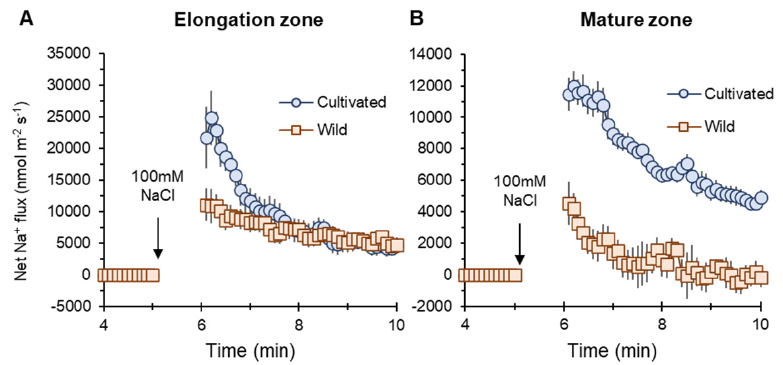
Figure 5. Transient net Na + flux measured from elongation ( A ) and mature ( B ) root zones of cultivated and wild rice species in response to 100 mM NaCl application. Mean ± SE ( n = 7–10).